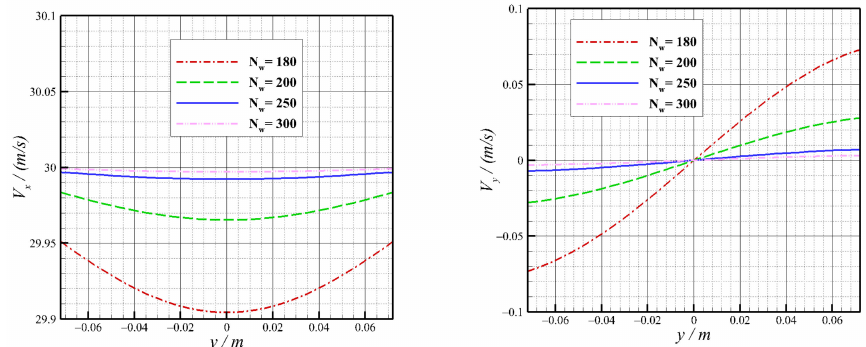
Figure 8. The effect of the discretization on the velocity.